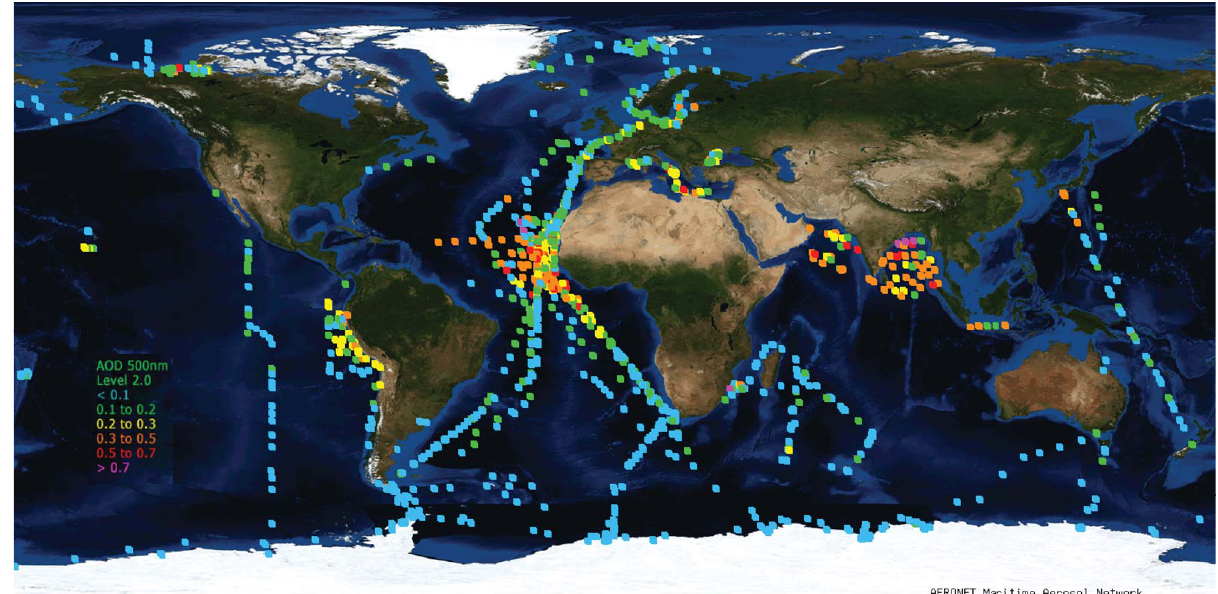
Fig. 2. Maritime Aerosol Network global coverage – cruise tracks and daily averages of aerosol optical depth at 500nm (squares are colored with respect to AOD values, i.e. blue – AOD < 0.10, green – 0.1 ≤ AOD < 0.2, yellow – 0.2 ≤ AOD < 0.3, orange – 0.3 ≤ AOD < 0.5, red – 0.5 ≤ AOD < 0.7, purple – AOD ≥